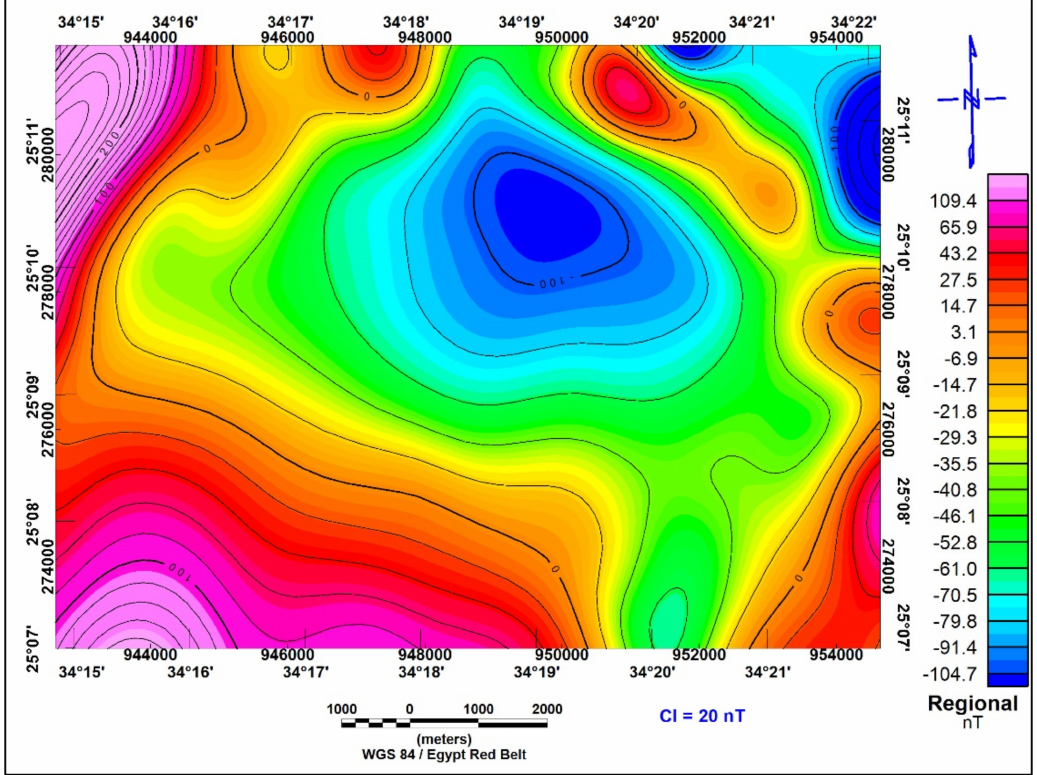
Figure 6. Regional airborne magnetic component of the RTP map of Homrit